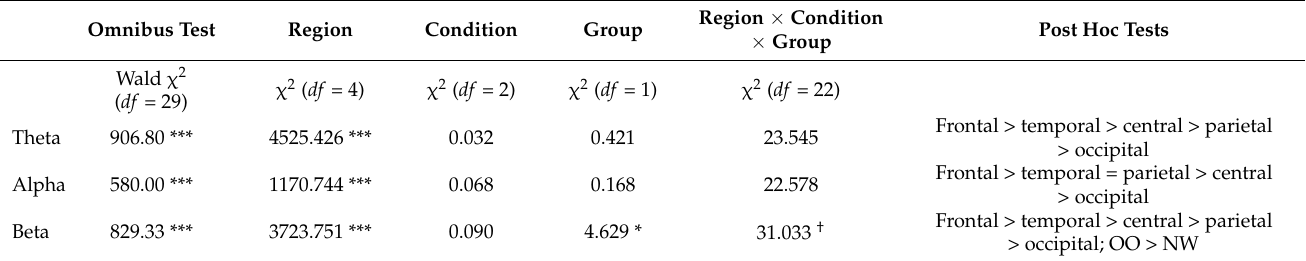
Table 3. Electroencephalographic activity for the theta, alpha, and beta band based on scalp region, condition, group, and their